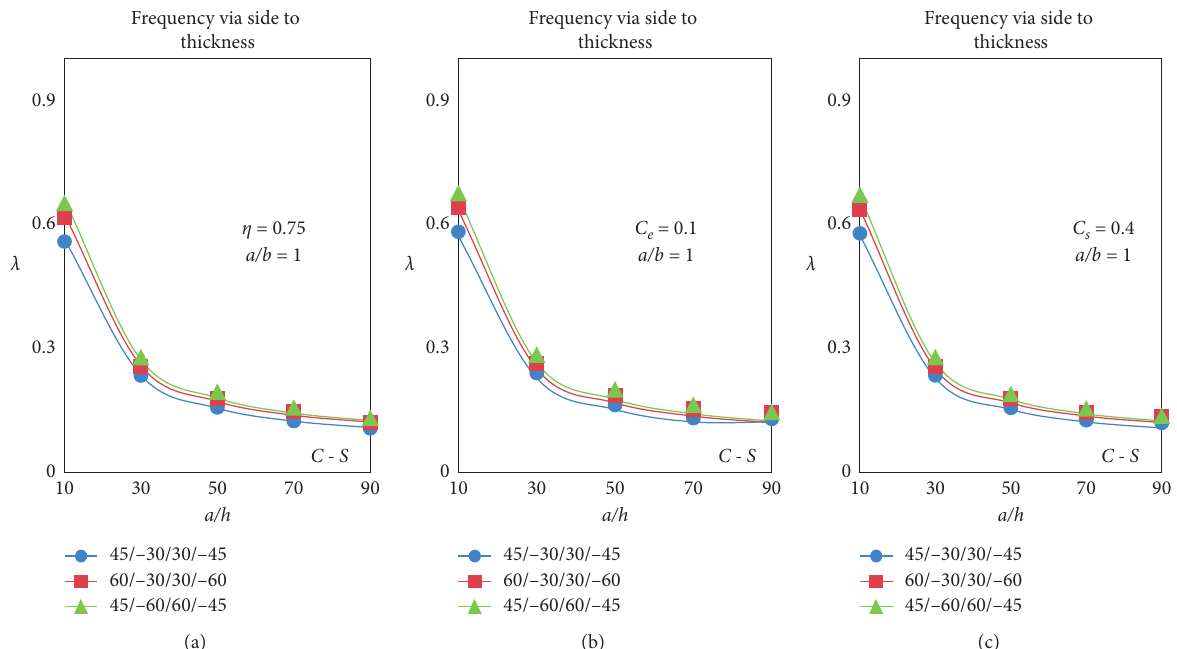
Figure 5: Impact of side-to-thickness ratio on frequency parameter value of 4-layered plates: